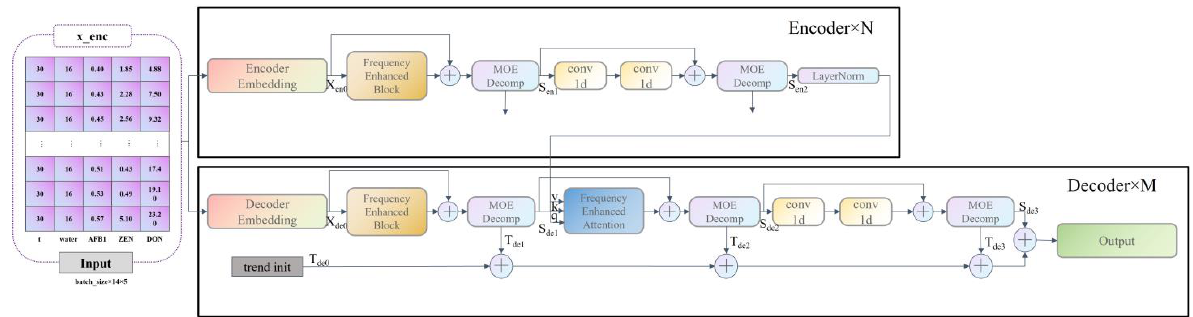
Figure 1. FEDformer Model.